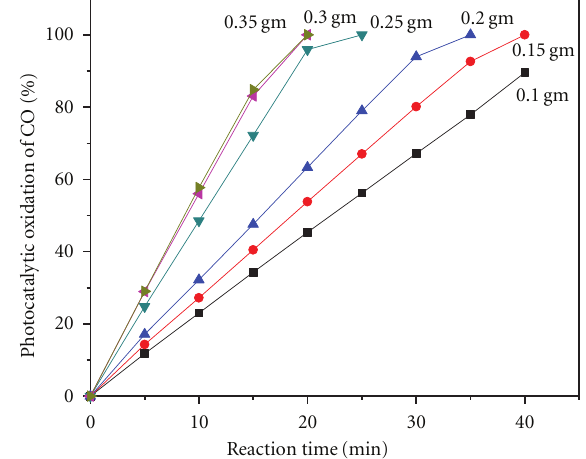
Figure 9: Photooxidation of CO over di ff erent loading from 33.3 mol% NiO/SnO 2 calcined at 550 ◦ C Figure 10. Kinetic for photooxidation of CO over loading from 33.3 mol% NiO/SnO 2 calcined at 550 ◦